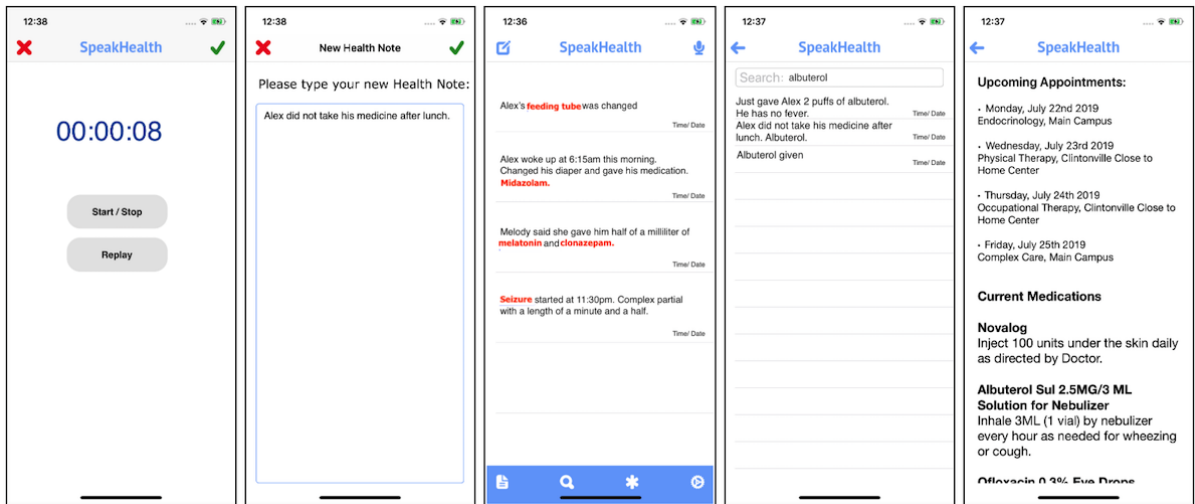
Figure 2. Screenshots of the SpeakHealth app. From left to right: voice interaction for note entry, note entry by text, notes overview and highlighted words, searching, and integration of medical information pulled from electronic health